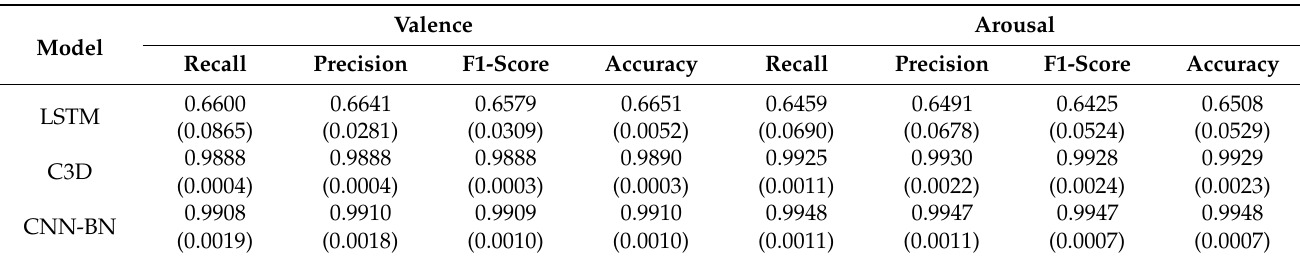
Table 2. Classification performance of the baseline models (LSTM and C3D) and the proposed CNN-BN model for valence and arousal. All performance evaluation results reported are the average (standard deviation) over five individual trials for each model.